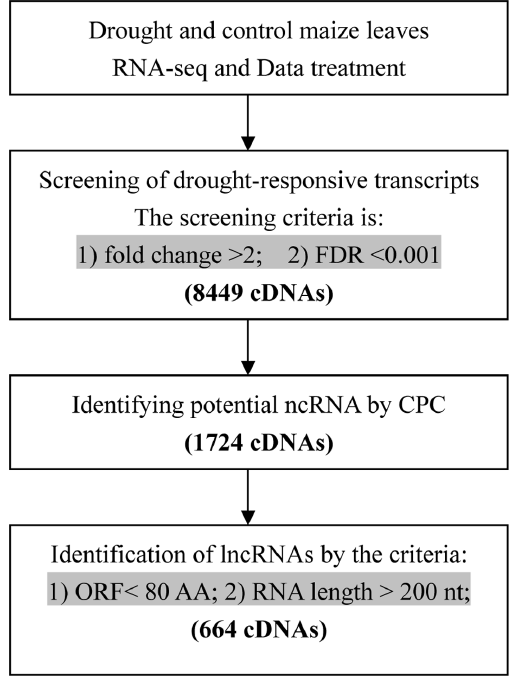
Figure 1. The flowchart for predicting non-coding RNA responsive to drought stress.